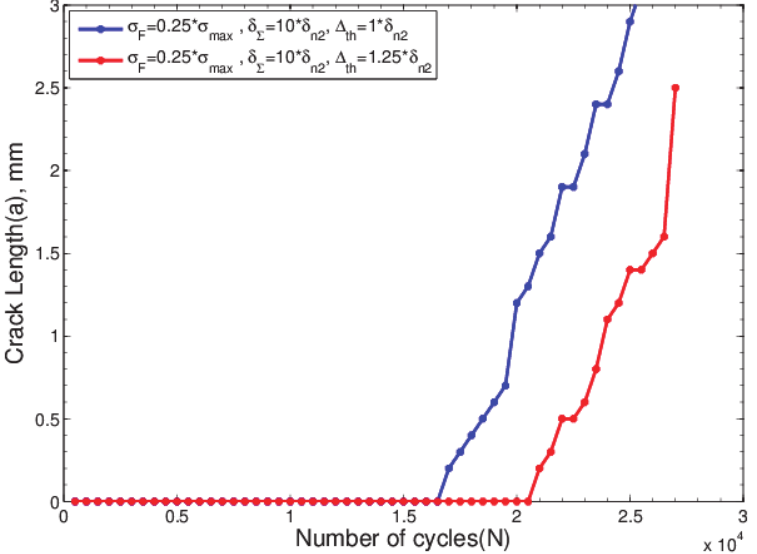
Figure 7: Effect of cohesive endurance limit ( σ F ) parameter on the fatigue crack growth